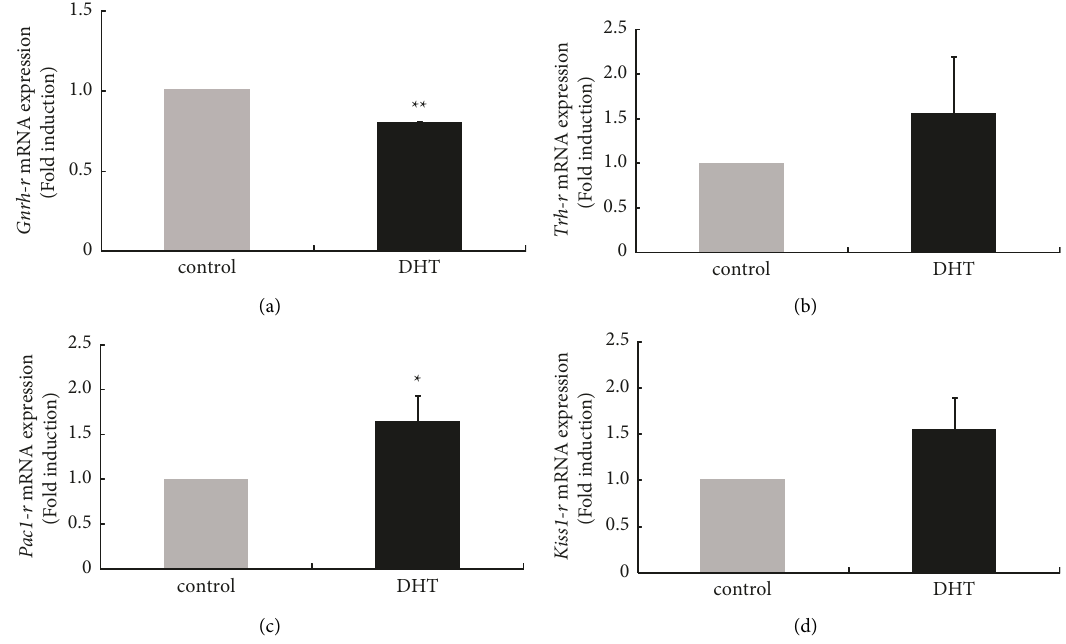
Figure 3: Effect of dihydrotestosterone (DHT) administration on receptor expression of hypothalamic peptides in the pituitary. Six-week- old female rats were injected subcutaneously with DHT (5mg/kg/day) daily for 7 days. After the rats were euthanized, the anterior pituitary was removed from nontreated ( n � 4) and DHT-treated rats ( n � 4), and then mRNA was extracted from the anterior pituitary tissue and reverse transcribed. Gnrh-r (a), Trh-r (b), Pac1-r (c), and Kiss1-r (d) mRNA levels were measured by quantitative RT-PCR. Samples from each experimental group were run in duplicate and normalized to the mRNA levels of the housekeeping gene Gapdh. The results are expressed as fold induction over the control and presented as the mean ± SEM. ∗∗ P < 0 . 01, ∗ P < 0 . 05 versus the